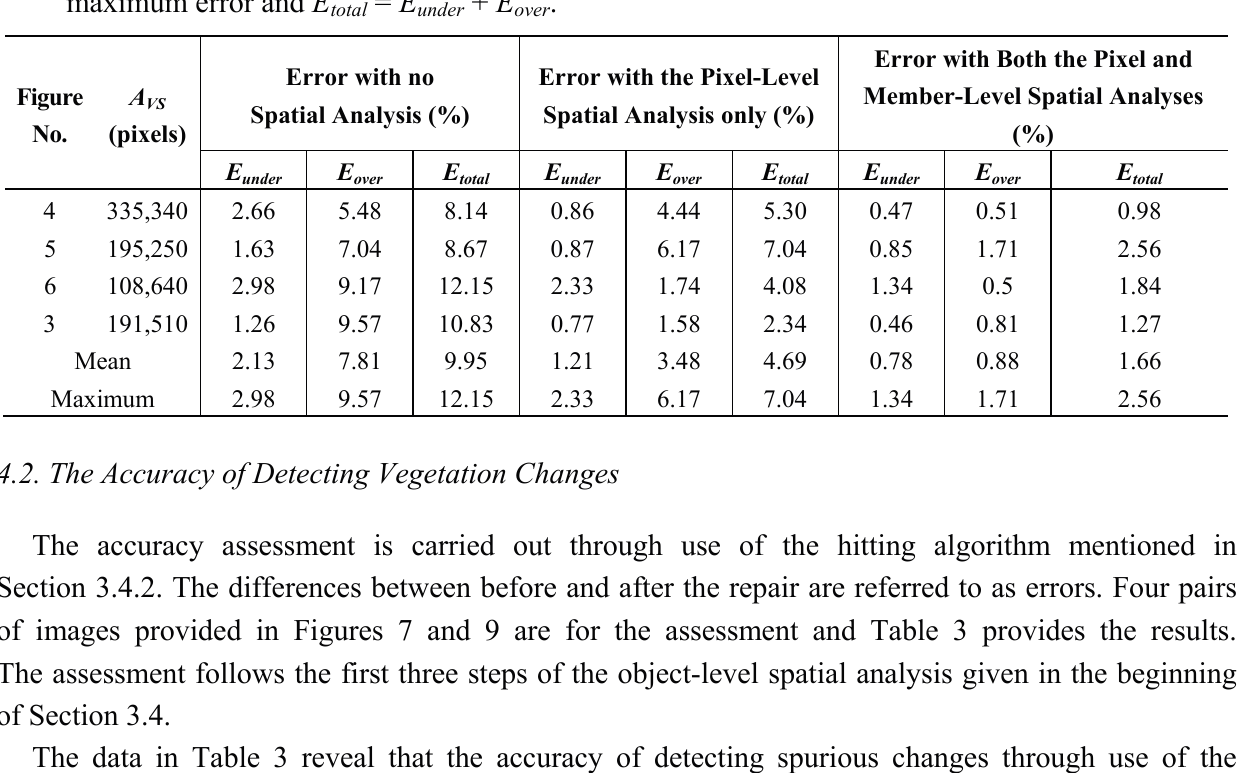
is the area of total VS = ( A / A ) × 100(%) where A and over over VS under is the total